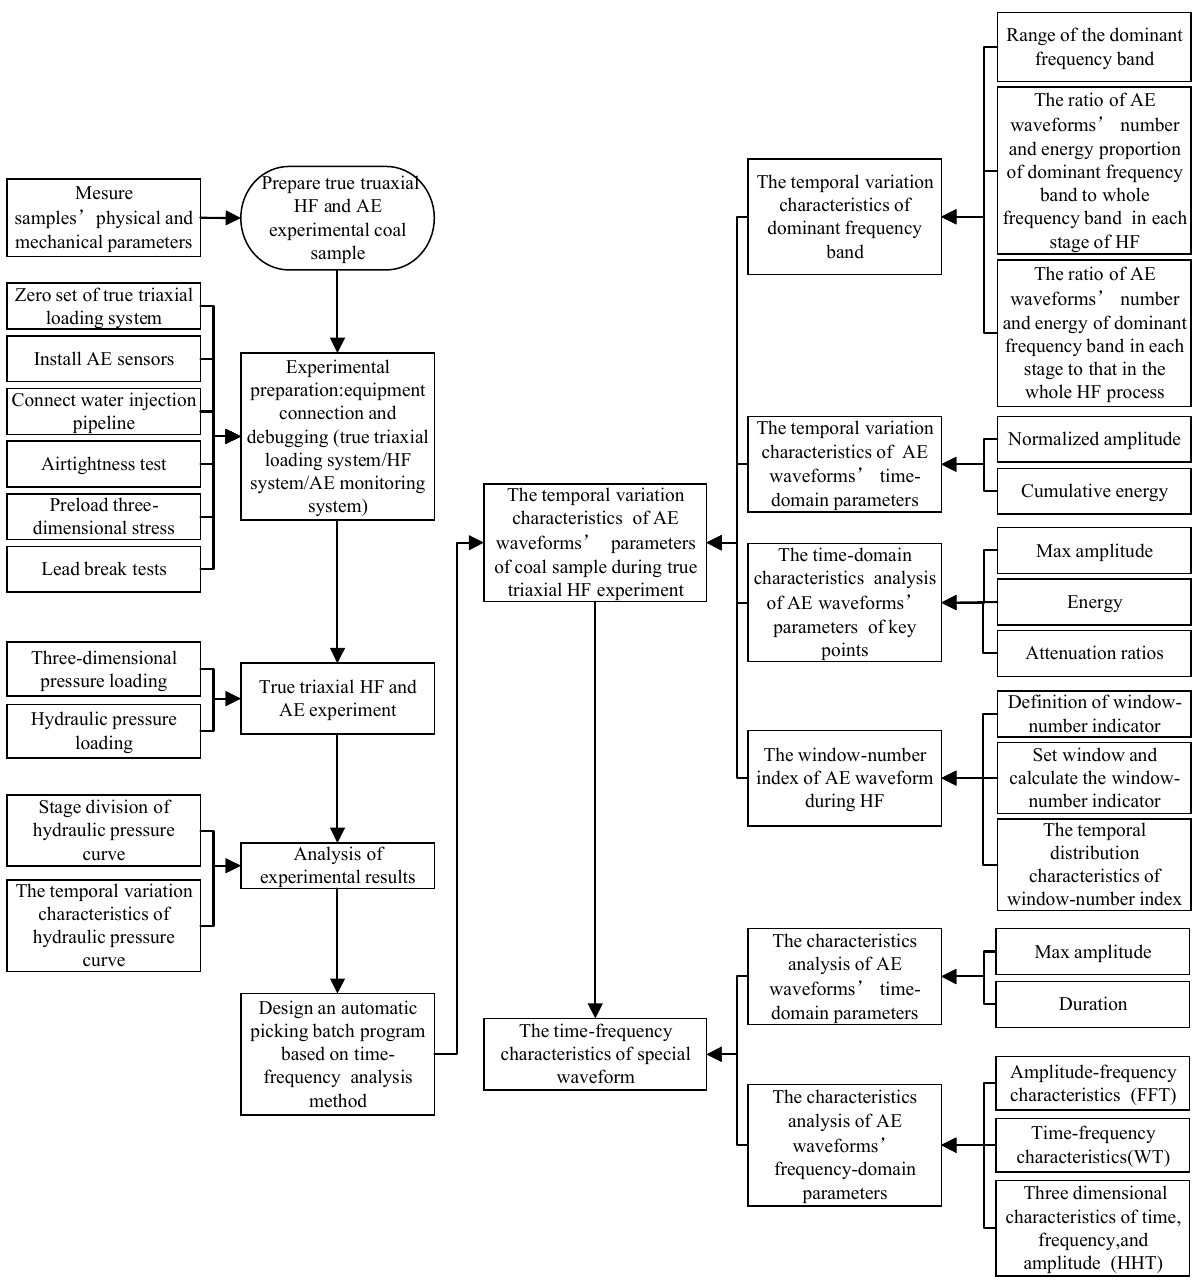
Figure 3. Flow chart of true triaxial HF and AE monitoring experiment for coal samples.